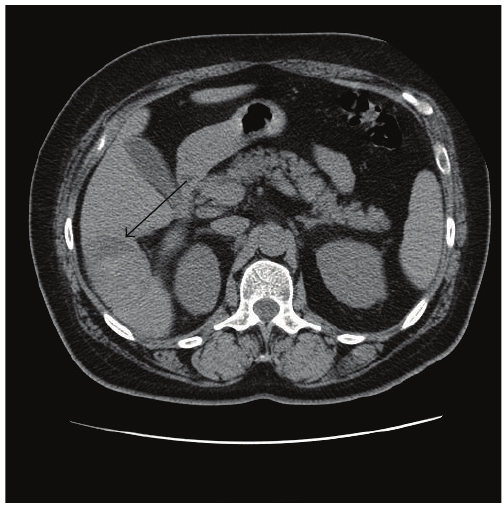
Figure 3: Reimaging of the abdomen with computed tomography three days subsequent to the original study demonstrates further increase in size of the ruptured hemangioma, and it now measures 61.5 mm.